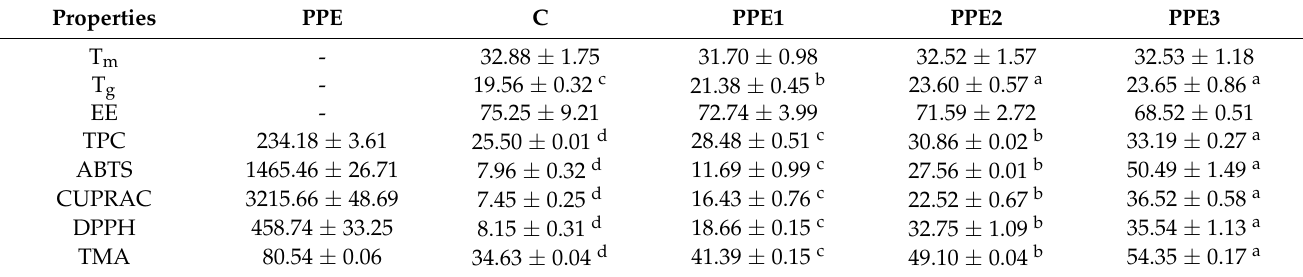
Table 1. The melting and gelation temperatures of “Boba” mix and bioactive properties of “Boba